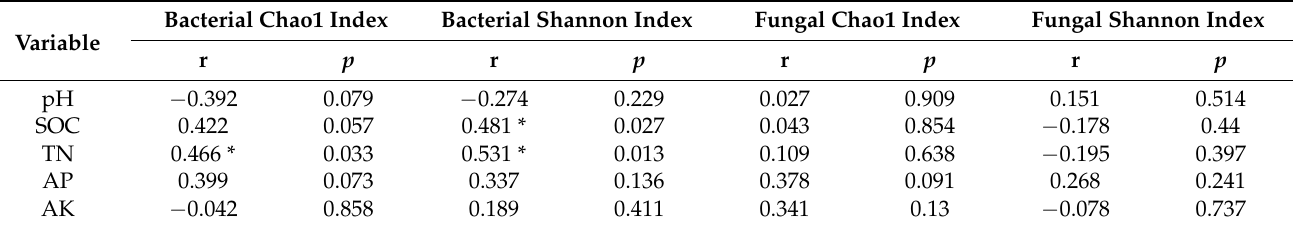
Table 2. Spearman correlation coefficients (r) between soil bacterial and fungal diversity (Chao1 index, Shannon index) and soil properties.